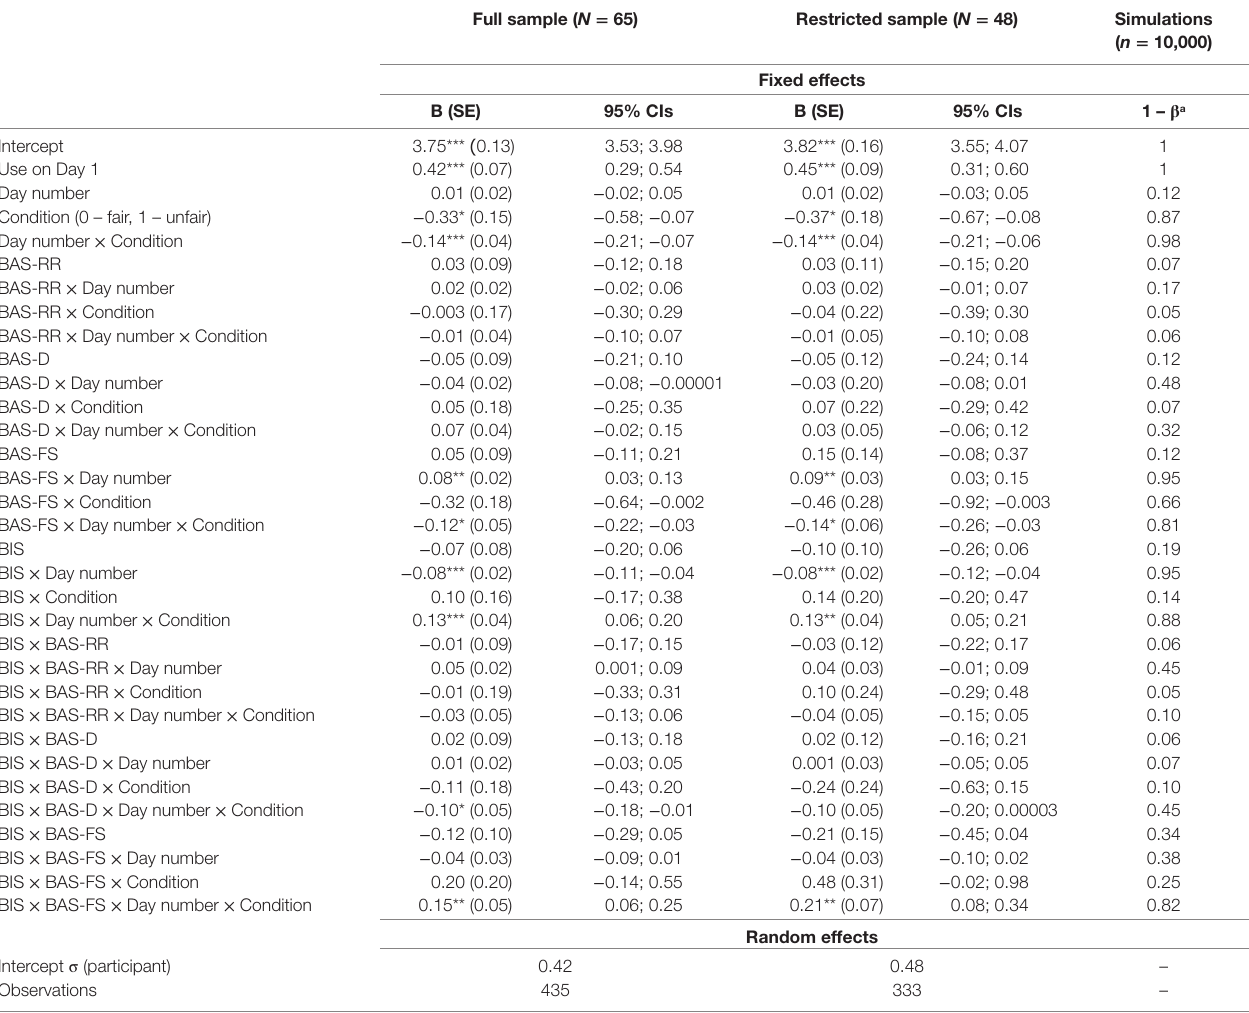
TaBle 4 | Model 2: mixed-effects random intercept regression model predicting the usage on day i .